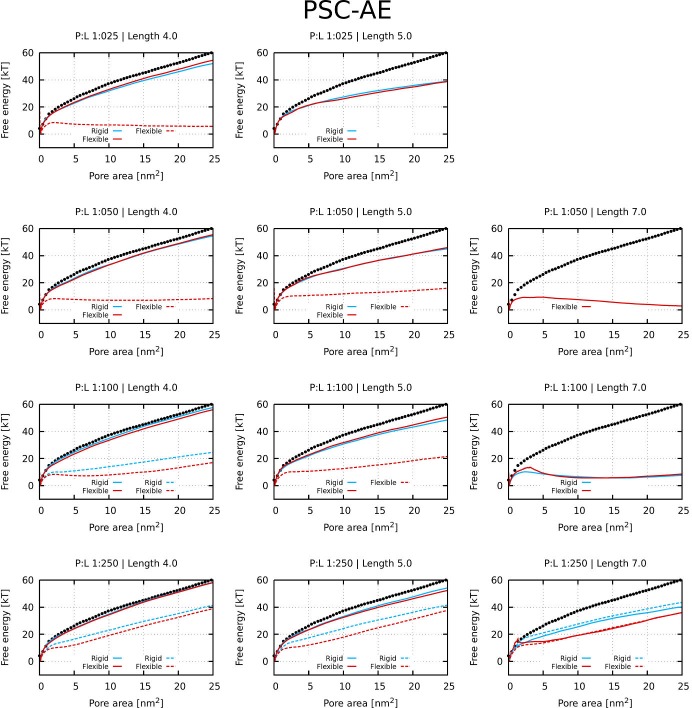
Free energy profiles of pore formation by PSC-AE peptides.Standard and more hydrophobic PSC-AE peptides are shown in full and dashed lines, respectively. The dotted line corresponds to the free energy profile of our reference system, a pure membrane without any peptides.